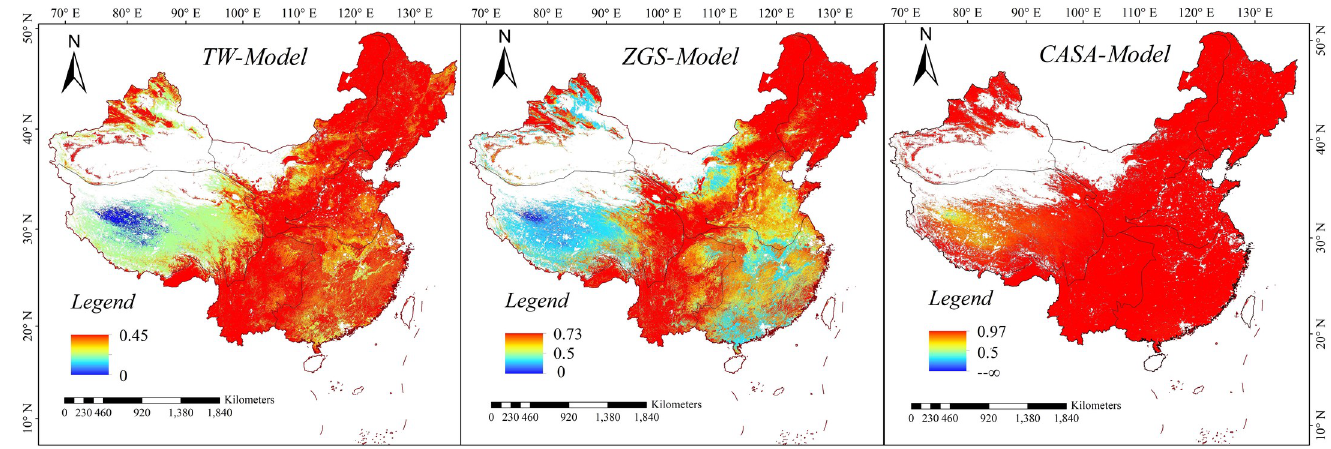
Fig 6. The spatial distribution of NSE of three models compared with MODIS NPP product.